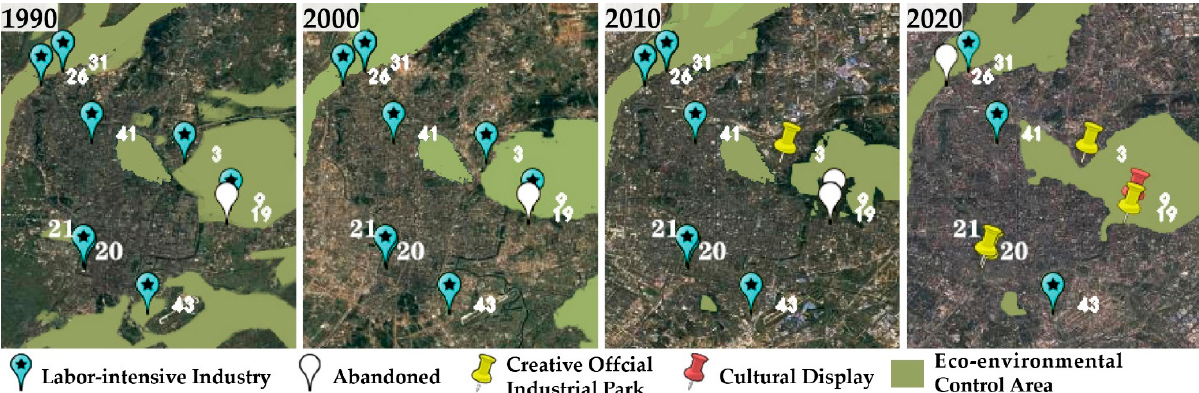
Figure 11. The change in the relationship between the operation state of labor-intensive industries and the eco-environmental control area over time (Figure source: own drawing; data source: on-site investigation and interview).